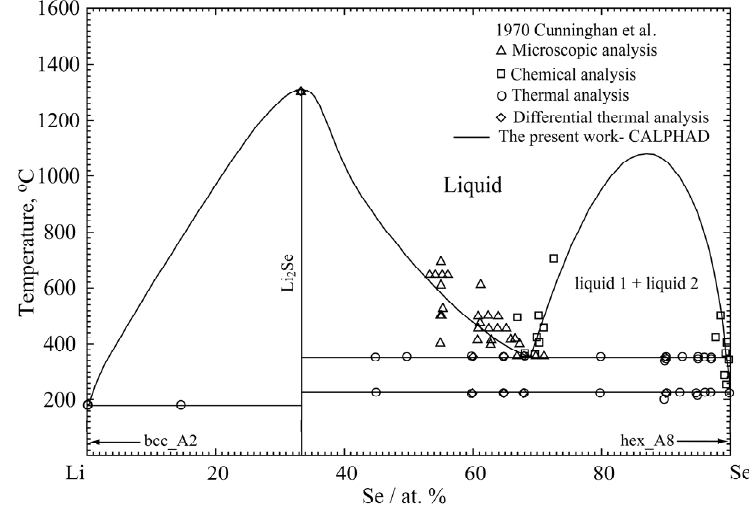
Figure 4. The calculated phase diagram of the Li-Se binary system compared with the experimental data [27].